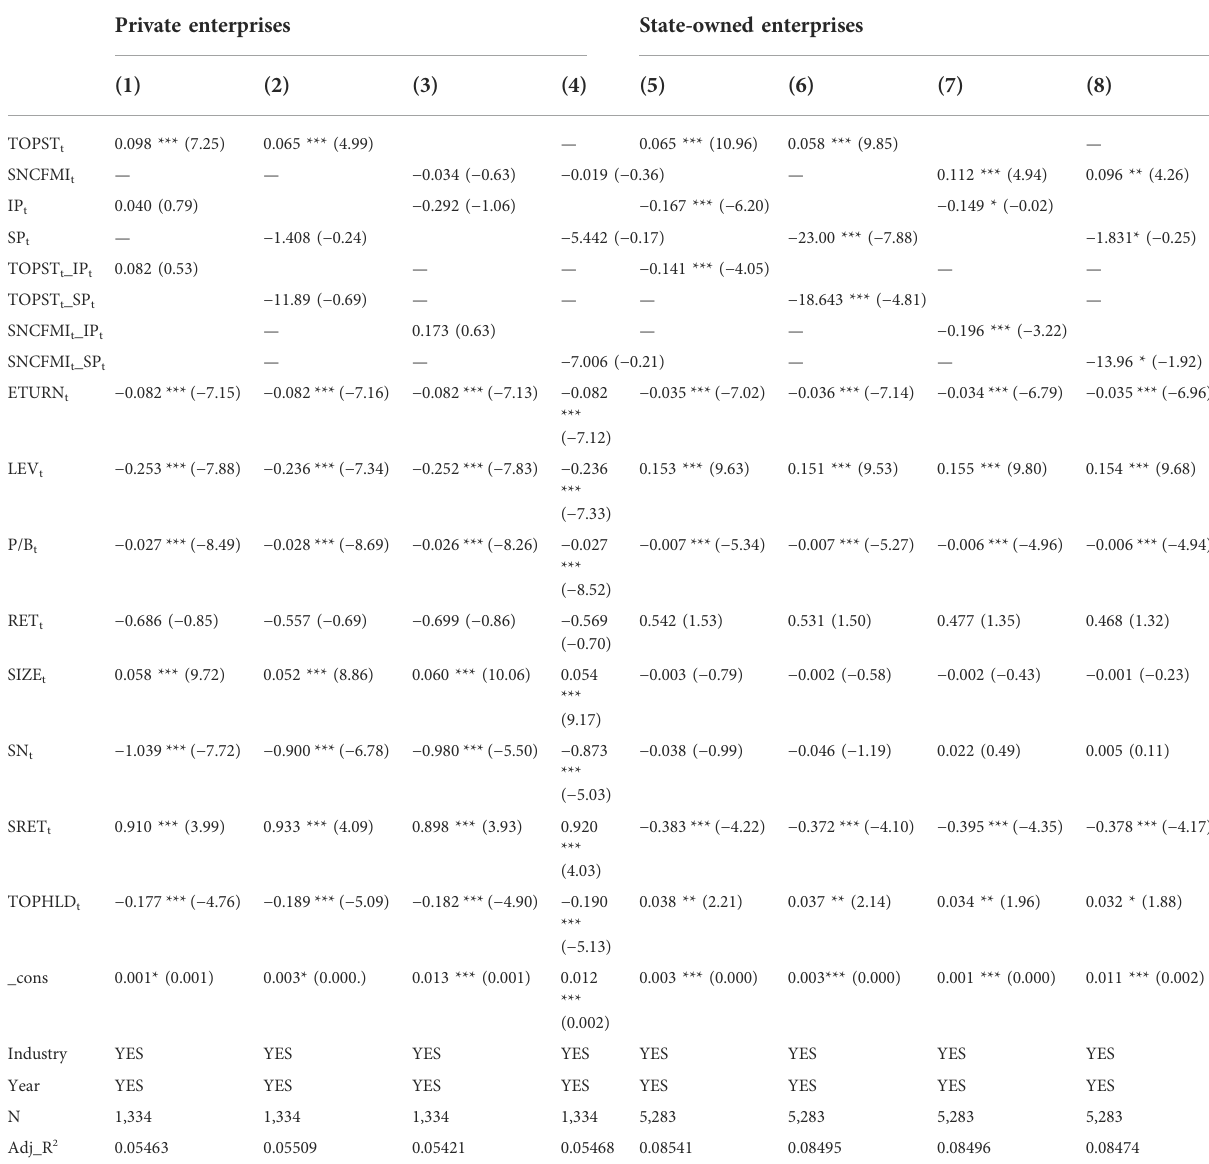
TABLE 3 Regression result of the split sample of private enterprises and state-owned